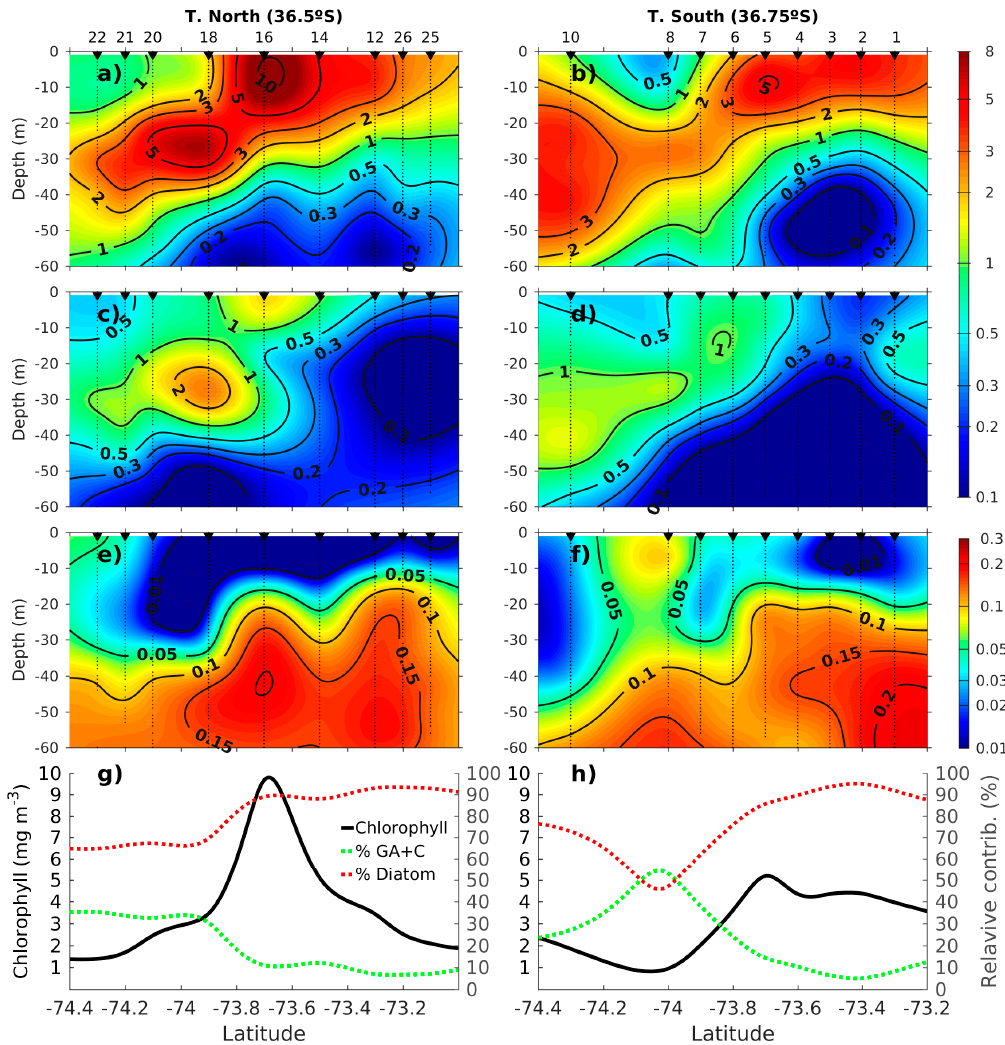
Figure 2. In situ FluoroProbe profiles during the PHYTOFRONT cruise: north and south transects (see Figure 1). The Chl-a concentration (color scheme; mg m − 3 ) associated to: Diatom ( a , b ); and Green Algae and Cryptophyta (GA+C; ( c , d )); ( e , f ) color dissolved organic matter (CDOM) relative concentration; and ( g , h ) the average Chl-a concentration (black line) in surface waters (first 20 m depth) and the relative contribution of Diatom (red dashed lines) and GA+C (green dashed lines) to surface Chl-a.